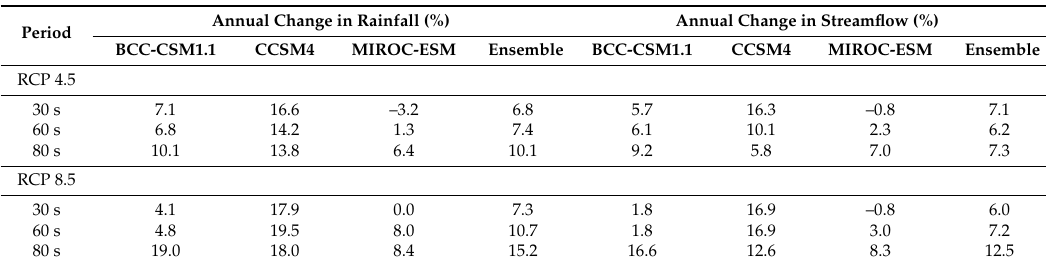
Figure 8. Total annual future rainfall and trends for: ( a ) RCP 4.5 ( top ); and ( b ) RCP 8.5 ( bottom ) in the BRB. Table 8. Variations in annual rainfall and streamflow under the RCP 4.5 and RCP 8.5 scenarios in the three future periods, relative to the baseline period